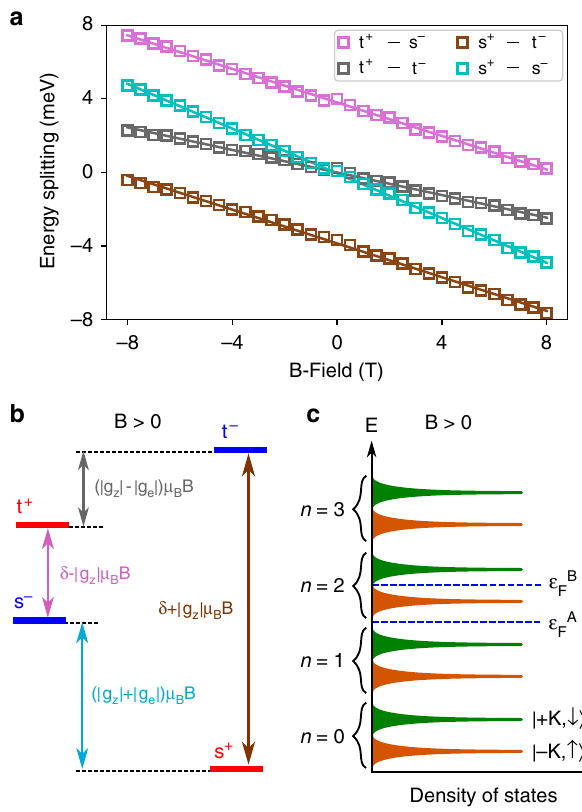
Fig. 4 The valley Zeeman effect of trions in WSe 2 . a Photon energy separation as a function of external B- fi eld between oppositely circularly polarized trion con fi gurations, calculated from E ( σ + ) − E ( σ − ) in photoluminescence. Open squares are data points, while solid lines are linear fi ts used to extract gradients. b Schematic of the energy separations between photon energies from each trion state when B > 0. Solid red or blue lines speci fi cally indicate photon energy in PL. The colour of text and arrows corresponds with the data in a . c Illustration of spin-valley polarized Landau levels in the band c1 when B > 0. The density of states is quantized into LLs separated by the cyclotron energy due to the B - fi eld. These LLs then split into pairs due to the magnetic moment of the band c1. ε A indicate the Fermi energy in two different scenarios A and B described in the main